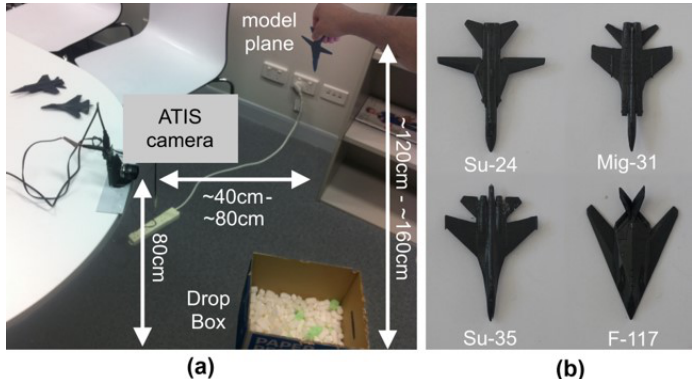
Figure 5. The setup for the collection and creation of the plane dropping event-based